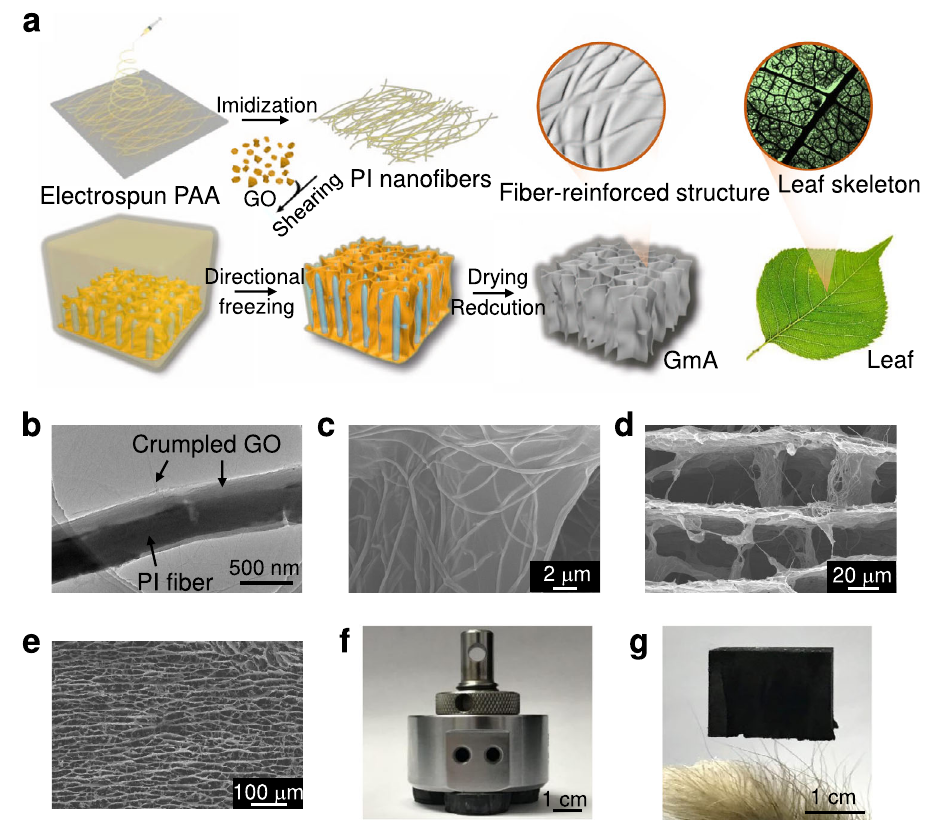
Fig. 2 | Fabrication and structure of graphene meta-aerogels (GmAs). a Schematicillustrations of fabrication procedures of the GmAsand a leaf with the optical photograph of the leaf skeleton. b TEM image of the graphene oxide (GO) sheets covering polyimide (PI) nano fi bers. c – e The cross-section SEM images of